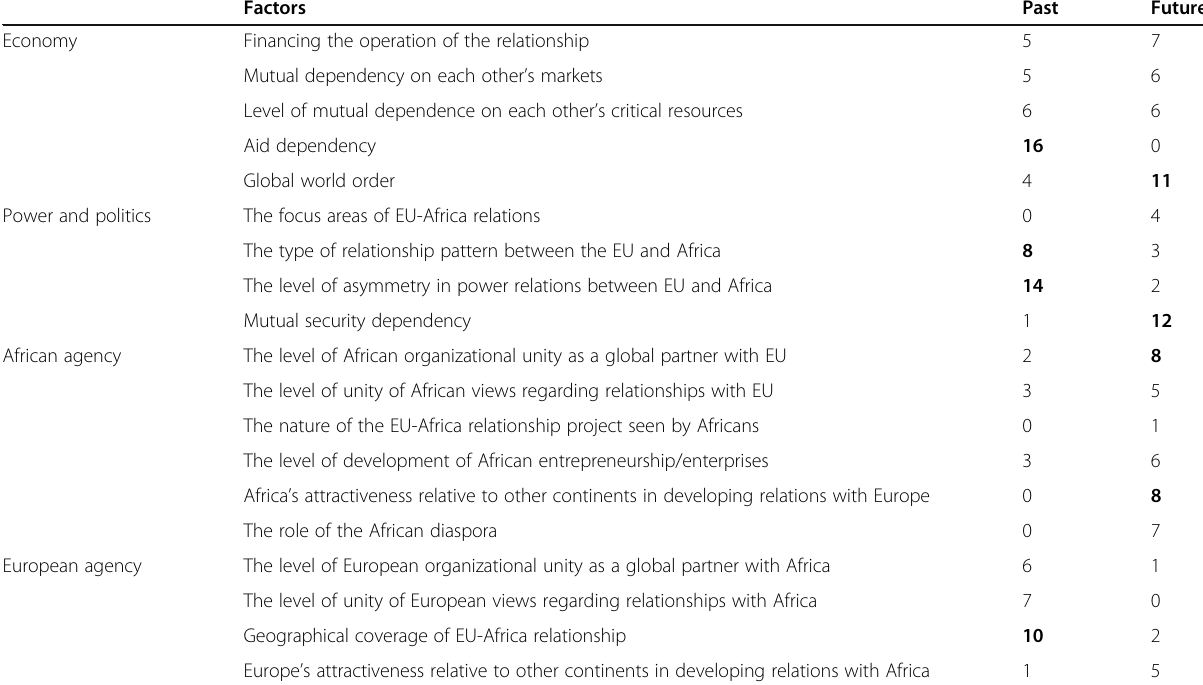
Table 1 Perceived past and future influences of the identified factors on EU-Africa relationship